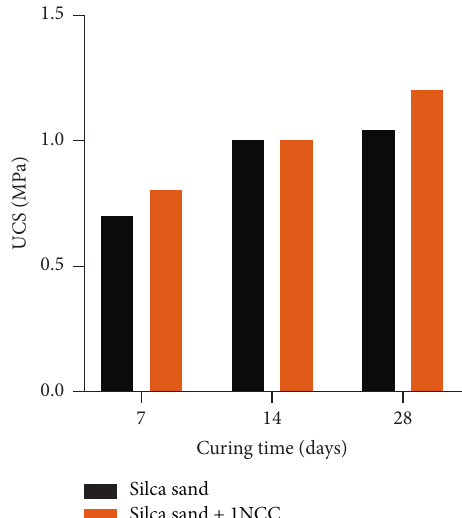
Figure 7: Mean unconfined compressive strength (UCS) of triplicate backfill samples prepared with silica sand without and with 1% nano- calcium carbonate (NCC). See Table 5, for the NCC mixture